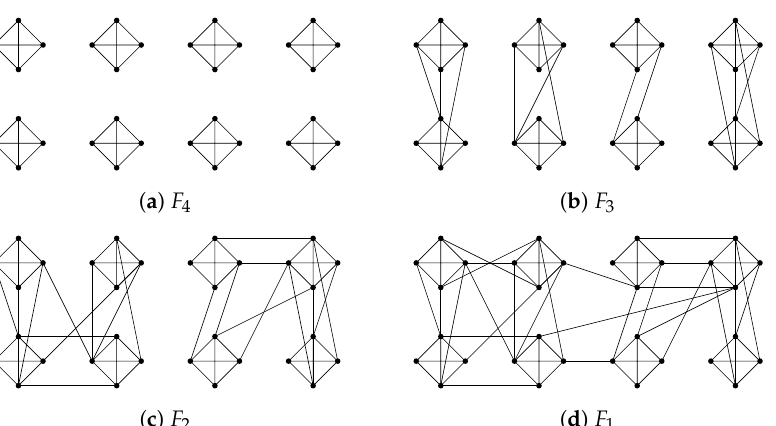
Figure 7. Four realizations of a random connection graph C that falls under four different cluster formations in a 4-level exponentially split cluster formation tree with δ =